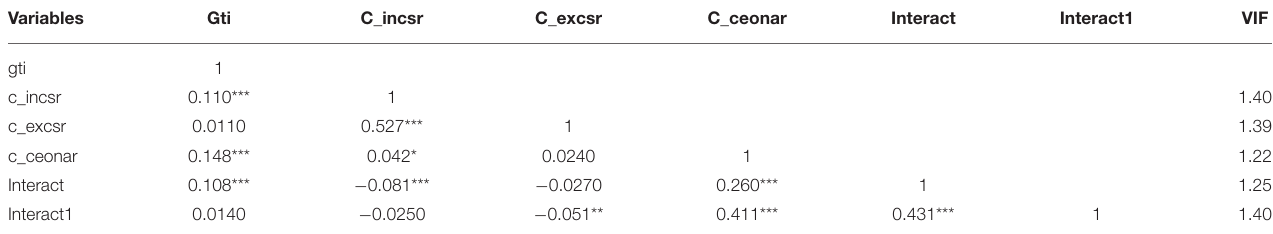
TABLE 6 | Correlations and VIF